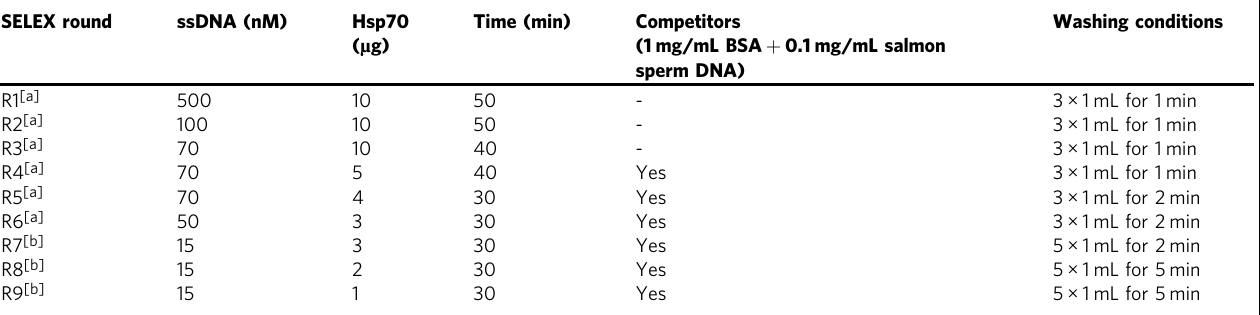
Incubation carried out in 250 µ L and at 24°C. [a] Negative selection performed against the beads only before incubation with the target. [b] Negative selection with His-NPA before incubation with the target.